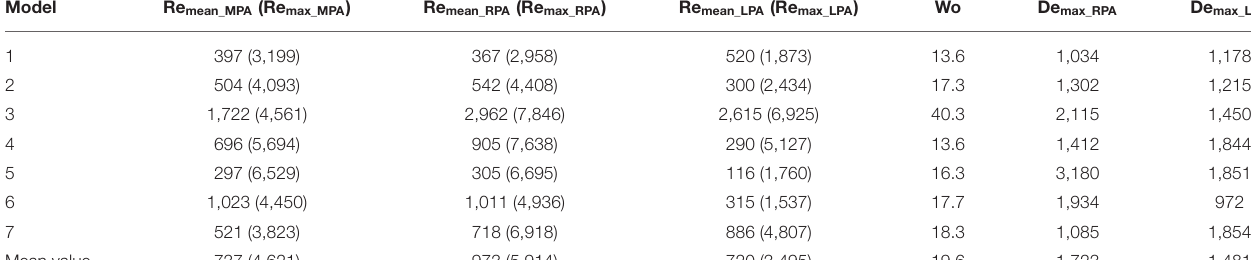
TABLE 4 | Mean and maximum Reynolds (Re), Womersley (Wo), and Dean number (De). Model